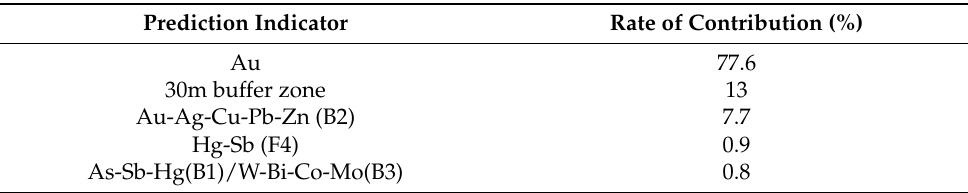
Table 4. Contribution rate of prediction